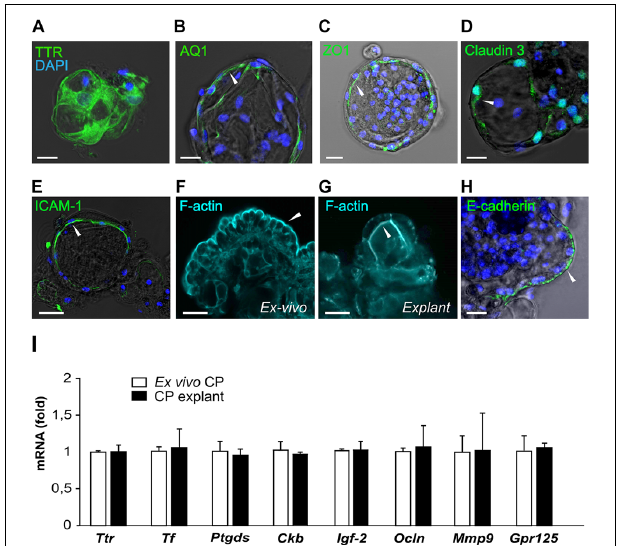
FIGURE 4 | CP explants show typical CP markers. (A–E) Presence of transthyretin (TTR), aquaporin 1 (AQ1), ZO1, Claudin 3 and ICAM-1 with DAPI (blue) staining in CP explants. White arrows indicate the localization of the staining on the apical or basolateral cell membrane (bar 20 µ m). Optical thickness of images sections 3 µ m. (F) Distribution of F-actin (cyan) detected by phalloidin in ex vivo CP fragment and explants (G) . (H) E-cadherin staining in a CP explant. (I) Expression of the CP epithelial markers, Ttr , lipocalin-type prostaglandin D Synthase ( Ptgds ), transferrin ( Tf ), creatine kinase brain ( Ckb ), occludin ( Ocln ), insulin-like growth factor 2 ( IGF-2 ) and G protein-coupled receptor 125 (GPR125) in native mouse CP (white bars) and CP explant at day 12 (black bars). n = 3 for explant series and n = 4 for CP